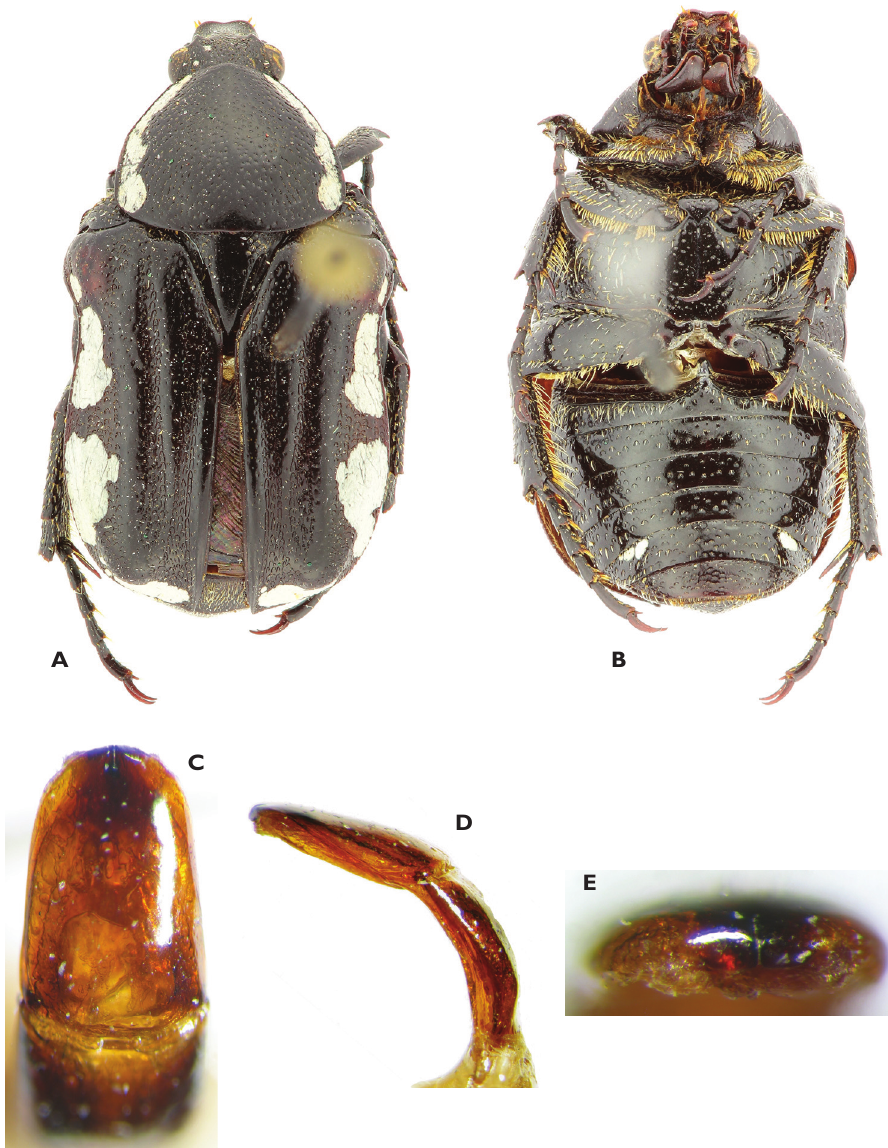
Figure 7. Atrichelaphinis ( Heterelaphinis ) nigra Antoine, 2002. Holotype male, Somalia (MNHN). A Dorsal view B ventral view C parameres in dorsal view D parameres in lateral view E apex of the